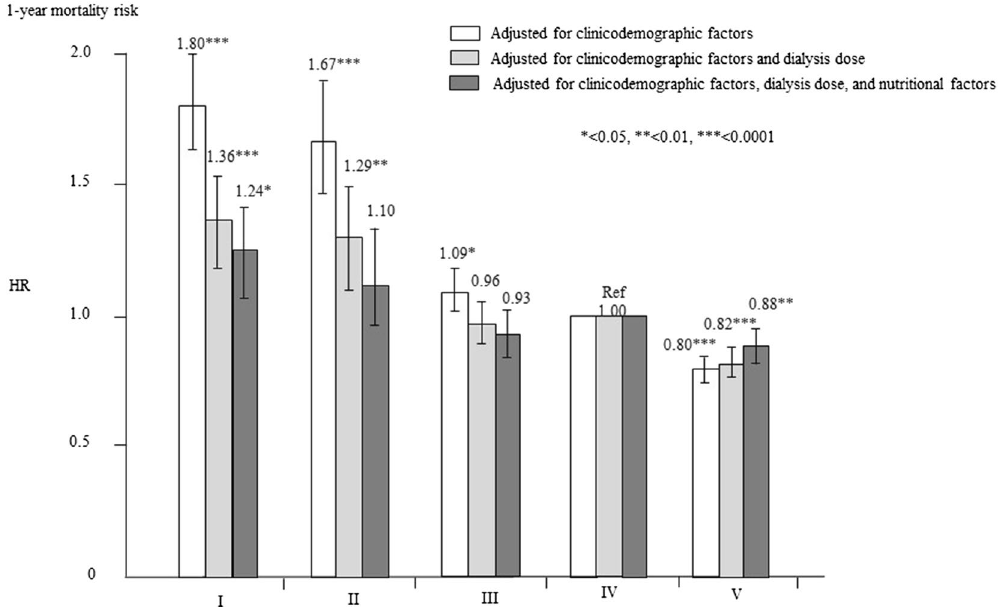
Figure 2. Hazard ratios of all-cause mortality for dialyzer type in 203,008 hemodialysis patients using a standard Cox proportional hazards regression. Bars with no fill are adjusted with clinicodemographic factors including age, sex, dialysis vintage, primary causes of end-stage kidney disease, and cardiovascular complication presence/absence. Gray-filled bars are adjusted with dialysis dose as assessed by Kt/V and β 2 -microglobulin levels in addition to clinicodemographic factors. Dark gray-filled bars are adjusted with clinicodemographic factors, dialysis dose, and nutrition- and inflammation-related factors, including body mass index, hemoglobin, C-reactive protein, and serum albumin levels, normalized protein catabolic rate, and simplified creatinine index. *P < 0.05, **P < 0.01, and ***P < 0.0001 versus the type IV dialyzer group. Error bars correspond to 95% confidence